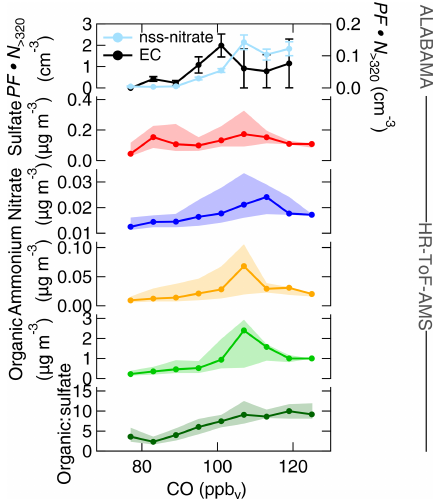
Figure 16. Aerosol composition measured by the ALABAMA and by the HR-ToF-AMS (indicated on the right side) as a function of CO mixing ratios during the southern air mass period. The top panel represents the scaled ALABAMA number concentration (PF · N > 320 ) with the right axis referring to EC-containing parti- cles (black) and left axis referring to nss-nitrate-containing particles (light blue). The lower panels represent each median (solid line with marker) and interquartile range (shaded area) of the HR-ToF-AMS mass concentrations of sulfate (red), nitrate (blue), ammonium (or- ange), organic matter (light green), and the organic-to-sulfate ratio (dark green). Uncertainty analyses are given in Sect.